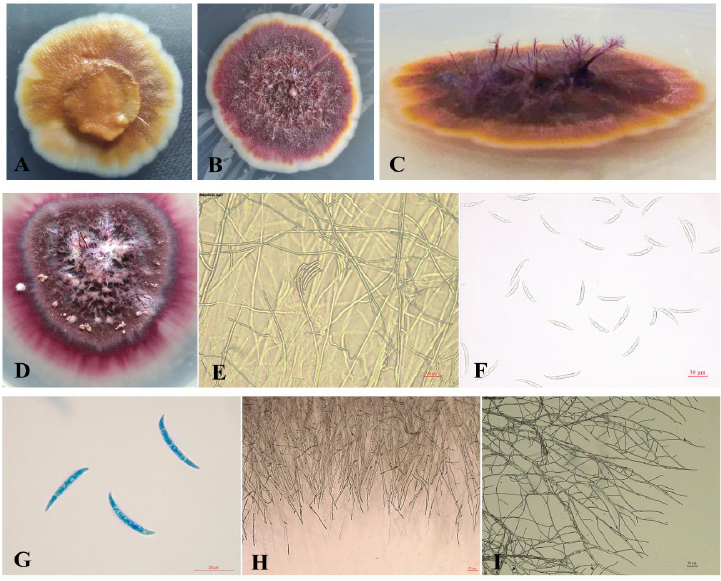
Figure 2. The morphology of antagonistic fungus J-1 grown on PDA medium for 10 d. (A) Slimy or yeast-like colony. (B–C) Crown mycelia. (D) Sticky spores group on PDA medium. (E) Phialidic conidi-ogenous cells. (F–G) Conidiophores. (H–I) Mycelial morphology. The scale bar in Figure 2E, 2F, 2G, 2H, 2I are 20 μm, 30μm, 20μm, 50μm, and 50μm respectively.